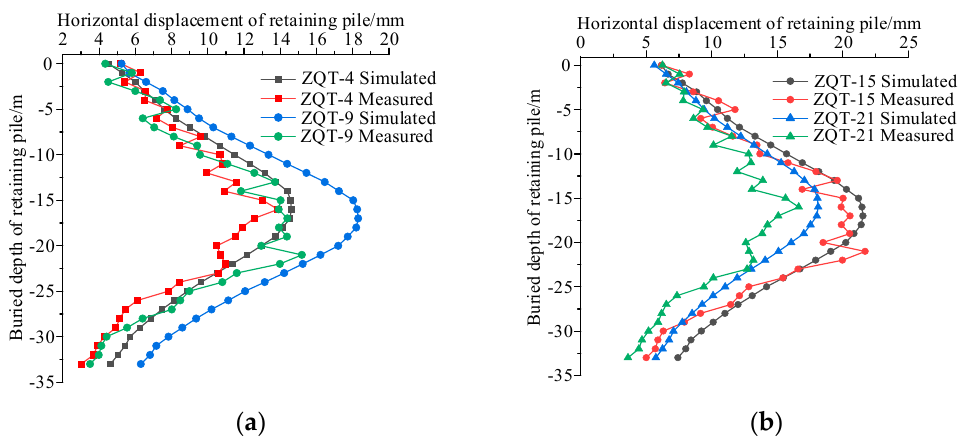
Figure 22. Comparison between the simulation and actual measurement of the horizontal displacement of the retaining pile. ( a ) Comparison of ZQT-4 and ZQT-9 data; ( b ) comparison of ZQT-15 and ZQT-21 data.